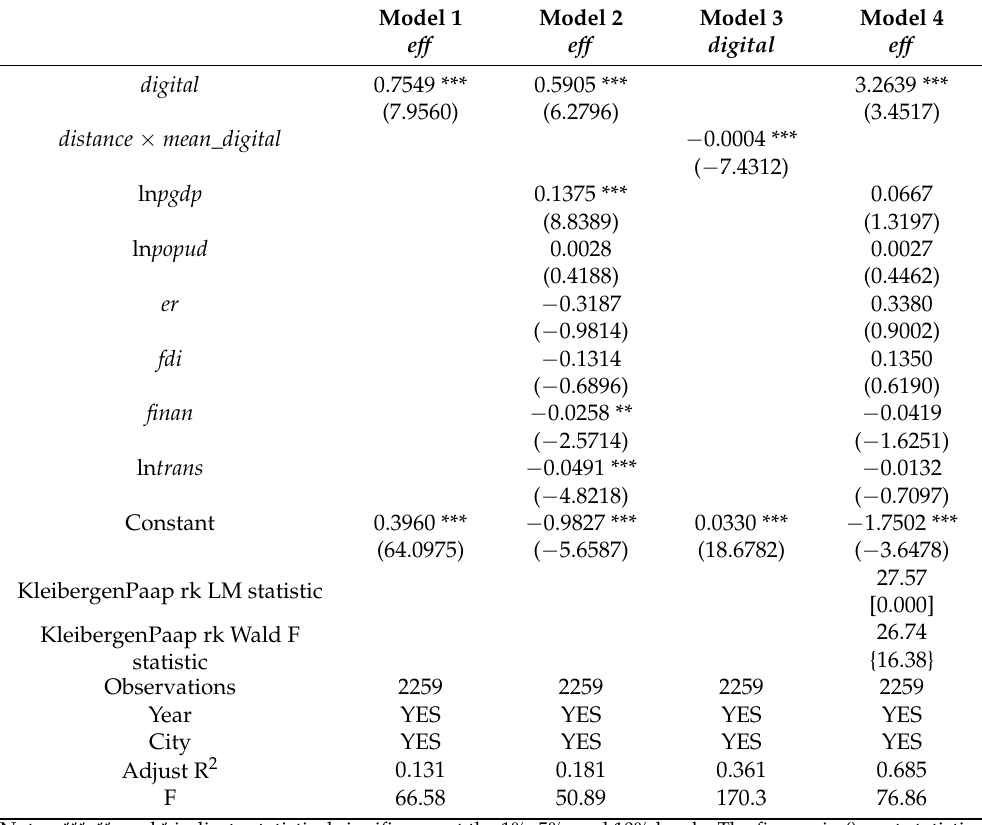
Table 4. Baseline regression results and instrumental variable test